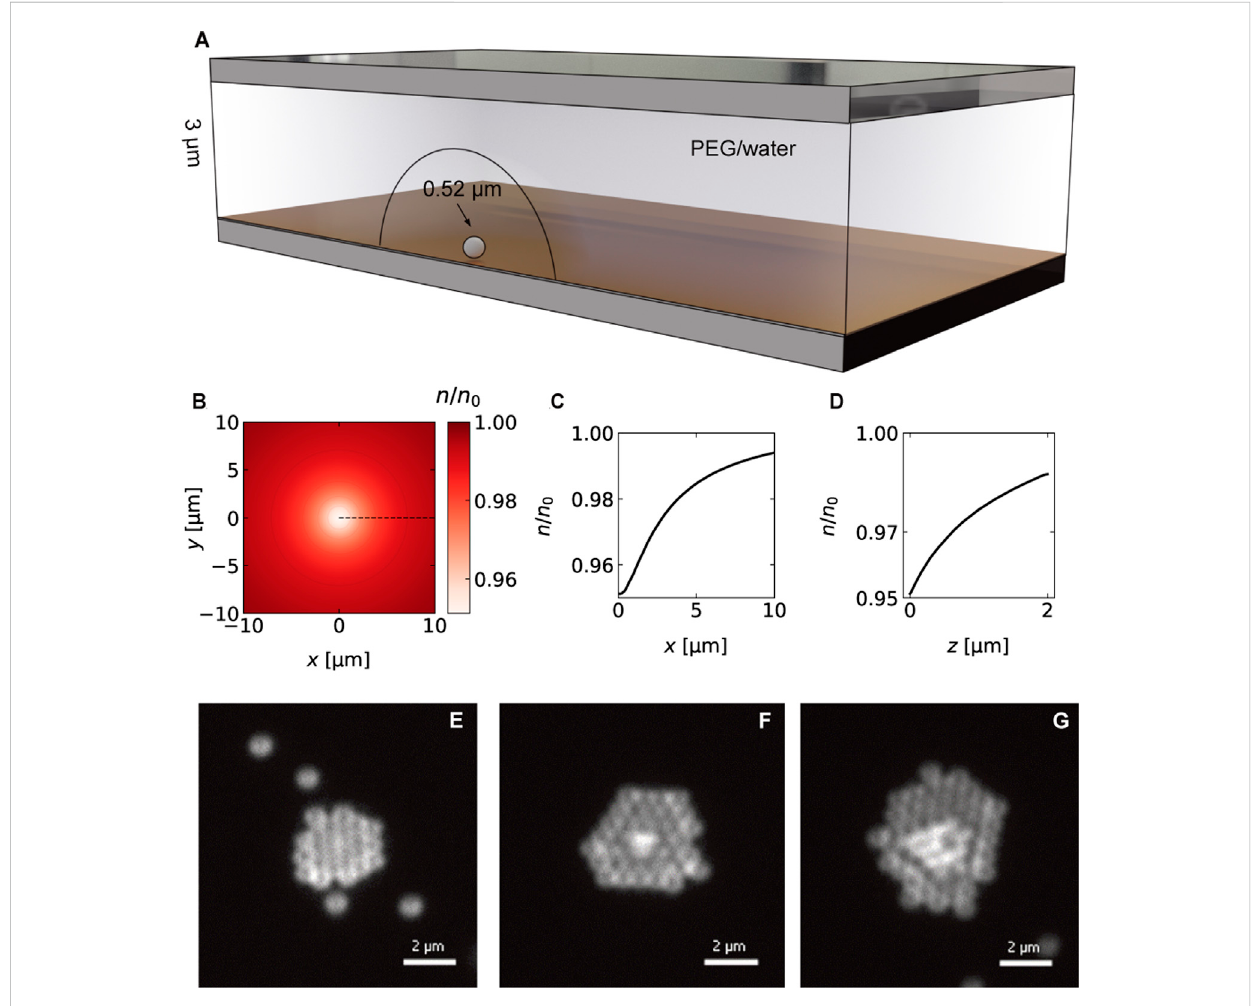
FIGURE 5 (A) Sketch of the colloidal crystal assembly of 518 nm PS particles in the presence of a depletion agent (5% (w/v) PEG 6000). Heating the metal fi lm creates a region of decreased PEG concentration that allows the crystal assembly. (B) Calculated relative concentration pro fi le (Top view) for p = 0.36 mW, Δ T max = 6.6 K using the COMSOl temperature pro fi le and a PEG Soret coef fi cient of S m T (cid:2) 0 . 05K − 1 . (C) Relative concentration pro fi les according to (B) in xy -plane, and (D) Relative concentration in xz -plane. (E – G) show the colloidal crystal formed (at p = 0.36 mW) after t = 30 s, 60 s and 120 s,